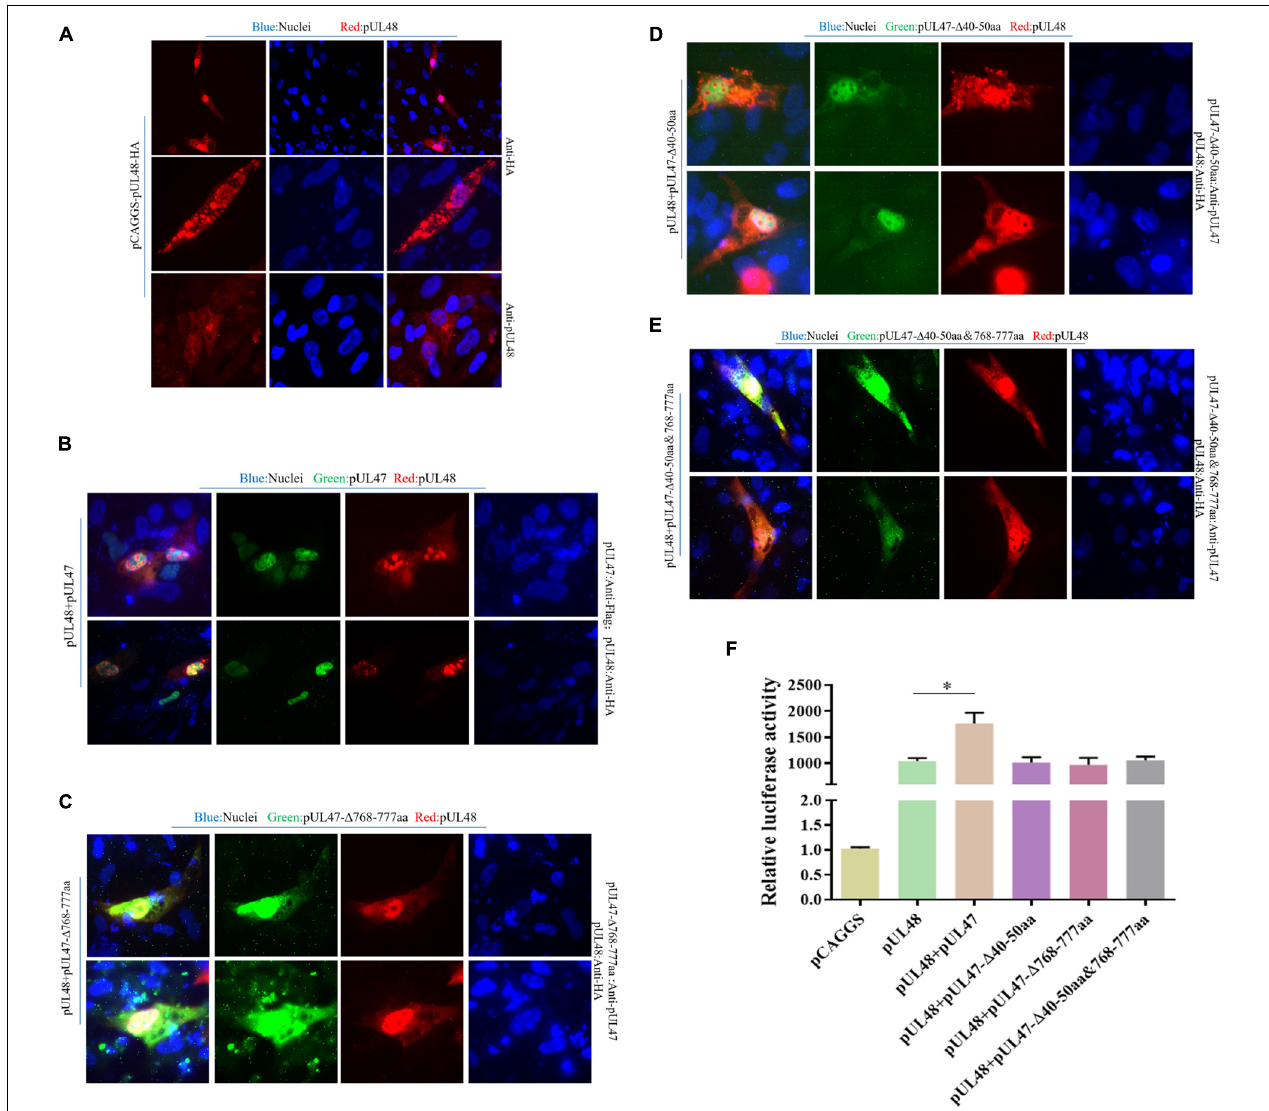
FIGURE 8 | Effects of pUL47 NLS on transcriptional activation of pUL48. (A) Cell localization of pUL48. (B) The effect of pUL47 on the nucleation of pUL48. (C) The influence of pUL47- (cid:49) 40–50 aa on pUL48 localization. (D) The influence of pUL47- (cid:49) 768–777 aa on pUL48 localization. (E) The influence of pUL47- (cid:49) 40–50 and 768–777 aa on pUL48 localization. First, pCAGGS-pUL48-HA was transfected separately. Then pCAGGS-pUL48-HA, pCAGGS-pUL47-Flag, pcDNA3.1-pUL47- (cid:49) 40–50 aa, pcDNA3.1-pUL47- (cid:49) 768–777 aa, and pcDNA3.1-pUL47- (cid:49) 40–50 and 768–777 aa with NLS deletion plasmids were cotransfected according to corresponding experimental groups, and indirect immunofluorescence assay was performed. (F) Effect of pUL47 NLS deletion on ICP4-Pro (1,235 bp) activation of pUL48. pCAGGS, pCAGGS-pUL48-HA, pCAGGS-UL47-Flag, pcDNA3.1-pUL47- (cid:49) 40–50 aa, pcDNA3.1-pUL47- (cid:49) 768–777 aa, and pcDNA3.1-pUL47- (cid:49) 40–50 and 768–777 aa were cotransfected into DEF with pGL4-ICP4-Pro (1,235 bp)-Luc and pRL-TK, except the reference plasmid pRL-TK. The transfection ratio of other plasmids with pGL4-ICP4-Pro (1,235 bp)-Luc was 1:1, and the transfection quantity of pRL-TK was 1/20 of pGL4-ICP4-Pro (1,235 bp)-Luc. Cell samples were collected 24 h after transfection, and ICP4-Pro (1,235 bp) promoter activity was detected by a dual-luciferase reporting system. Student’s t -test was used to analyze the differences of the two groups; ∗ p <